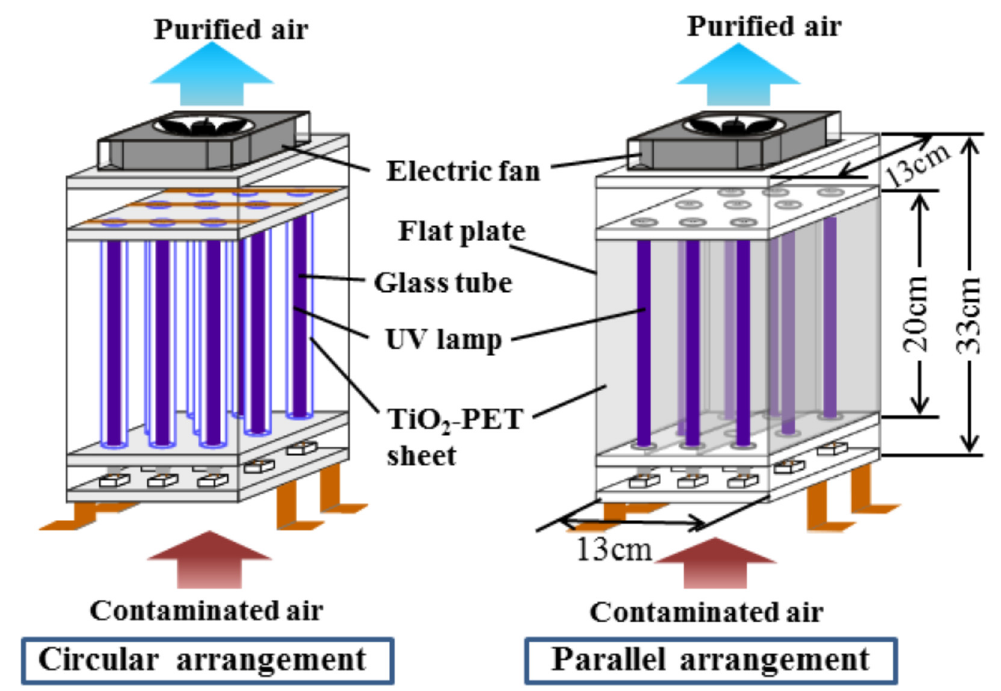
Figure 10. Arrangement of UV lamps and TiO 2 -PET sheets (surface area of the TiO 2 -PET sheet). [174] .